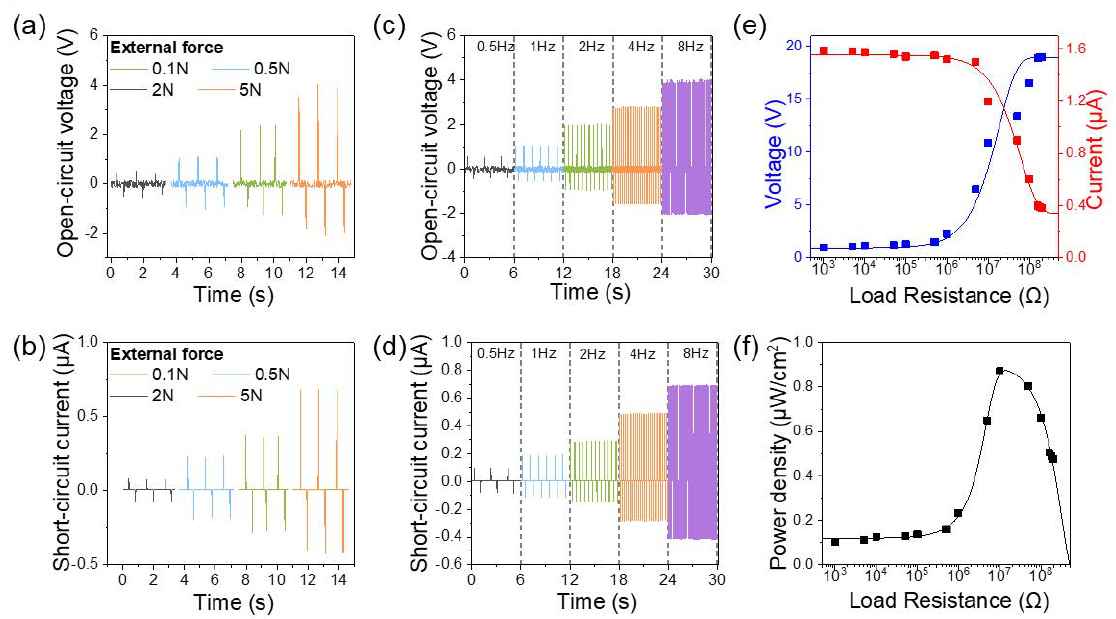
Figure 4. Output performance of the nonwoven TENG. ( a ) V oc and ( b ) I sc of the TENG under di ff erent external forces from 0.1 to 5 N. ( c ) V oc and ( d ) I sc of the TENG under di ff erent frequencies from 0.5 to 8 Hz. ( e ) Output voltage, current, and ( f ) output power density as functions of external load resistance from 1 k Ω to 100 M Ω , under the applied force of 5 N and frequency of 8 Hz.